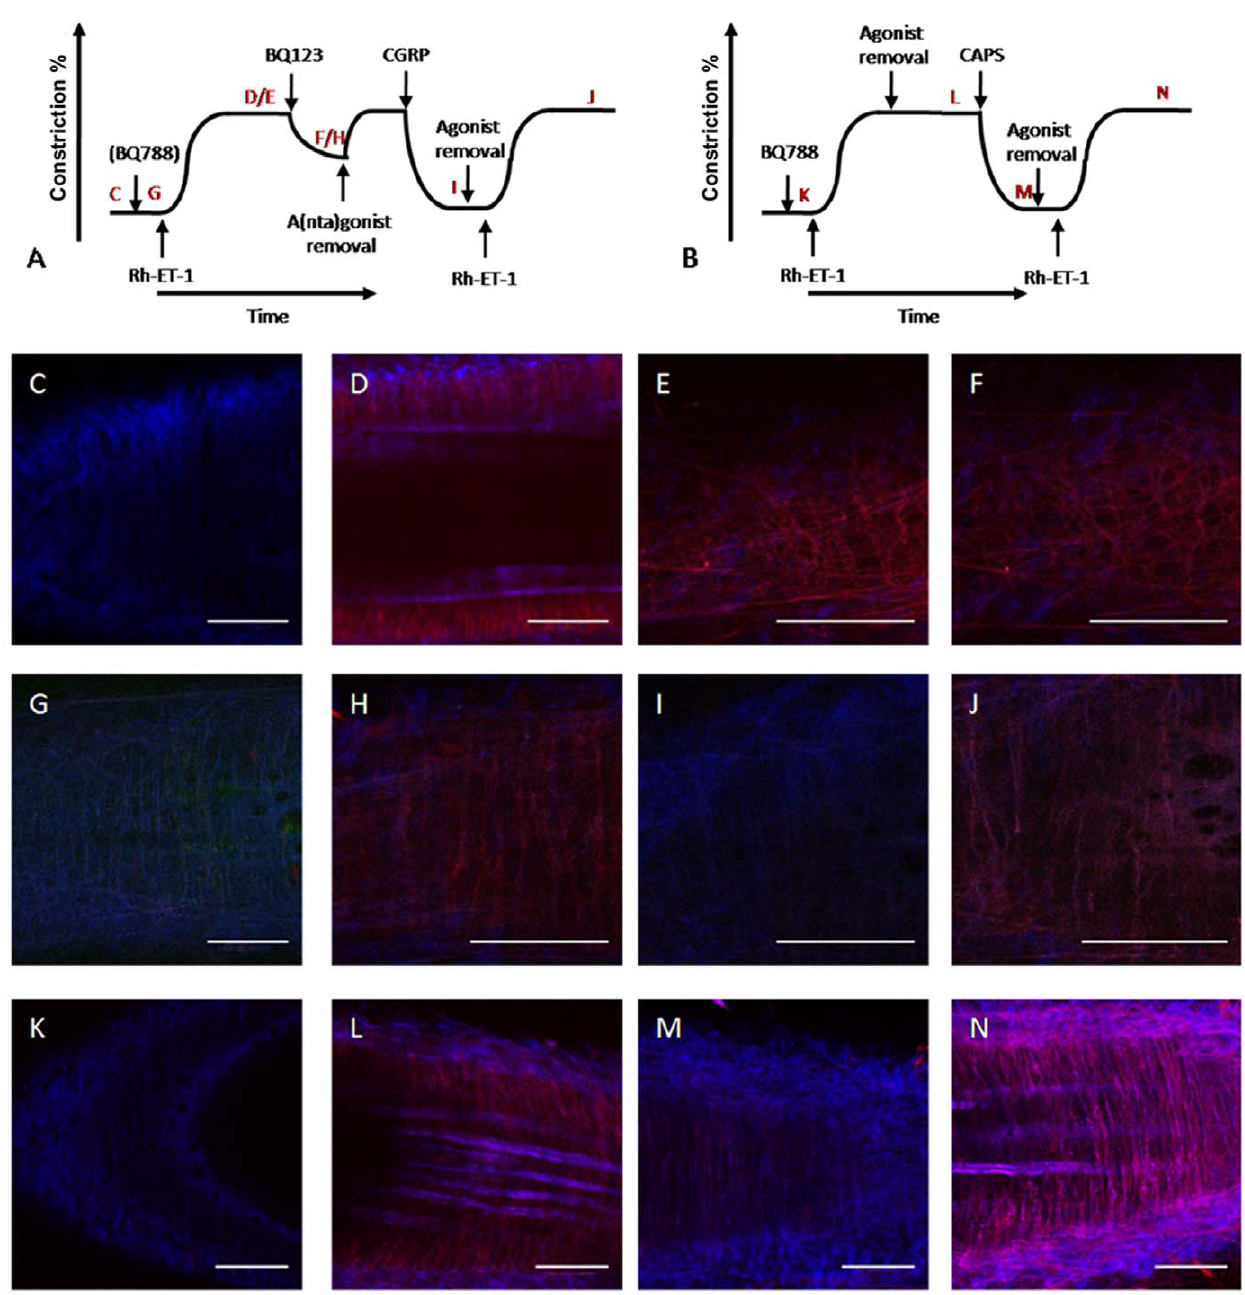
Figure 6. Binding of ET-1 is not reversed by ET-receptor antagonists (C-F) but can be reversed by CGRP (G-J) and by capsaicin (K-N). Isolated rat mesenteric arteries were canullated, pressurized and mounted under a 2-photon laser scanning microscope. Analyses focussed on the smooth muscle layer (bordered by the autofluorescent (blue) internal and elastic laminae) (C, G, H)). Experiments were performed in continuous presence of BQ788 (1 m M) except panels C and D. A and B illustrate schematic tracings of active wall tension versus time illustrating the order of (i) administration of rhodamine-labeled ET-1 (Rh-ET-1, 16 nM), (ii) application of pharmacological agents and (iii) removal of agonists and antagonists. C, autofluoresence. D - F, labeling of vascular smooth muscle (D, red) observed in presence of Rh-ET-1 is not noticeably affected by administration of BQ788 (E, 1 m M) and BQ123 (F, 1 m M). G, autofluorescence. H – J, labeling induced by exposure to Rh-ET-1 (16 nM) persists in absence of free label and is resistant to ET-receptor antagonists (H) but is rapidly abolished (I) by exposure of the artery to CGRP (100 nM); thereafter labeling of smooth muscle can be re-established by exposure to Rh-ET-1 (16 nM) (J). K, autofluoresence. L – N, largely similar experiment using capsaicin (CAPS, 1 m M). Labeling induced by exposure to Rh-ET-1 (16 nM) that persists in absence of free label (L) is abolished (M) by exposure of the artery to CAPS (1 m M); thereafter labeling of smooth muscle can be re-established by exposure to Rh-ET-1 (16 nM) (N). Scale bars: 50 m m. Findings are representative for 4 arteries of 3 rats.